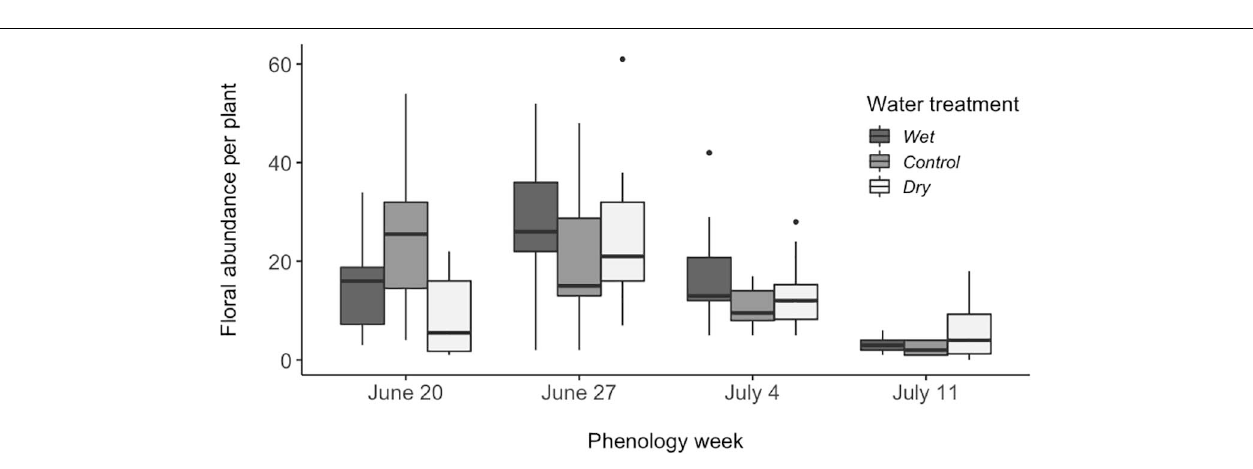
FIGURE 3 | Effects of experimental variation in soil moisture and flowering phenology on Mertensia ciliata floral abundance per plant ( N = 114). Week 4 (July 11) differed from the other 3 weeks (Tukey pairwise comparison among phenology weeks, P < 0.001). Significant interaction terms ( P < 0.05) were: week 1 vs. week 4 in wet vs. control, as well as control vs. dry treatments; week 1 vs. 2 in dry vs. wet as well as dry vs. control treatments; week 2 vs. 3 in wet vs. control; all treatment combinations in week 2 vs. 4; all treatment combinations in week 3 vs. 4. Boxplots follow the same conventions as in Figure 1